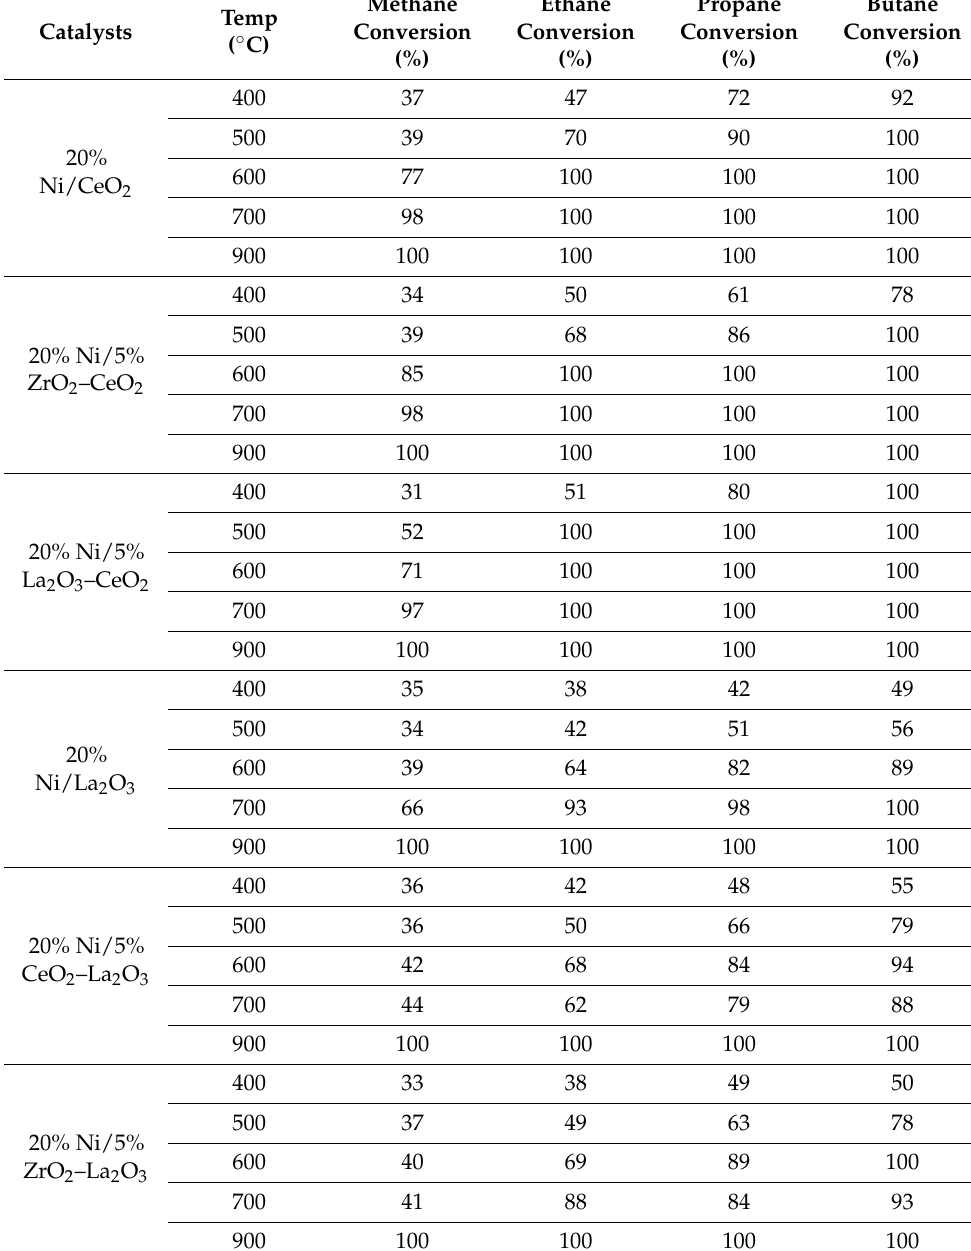
Table 5. Conversion values of the hydrocarbons obtained in the process of the oxy-steam reforming of liquefied natural gas (LNG) using supported nickel